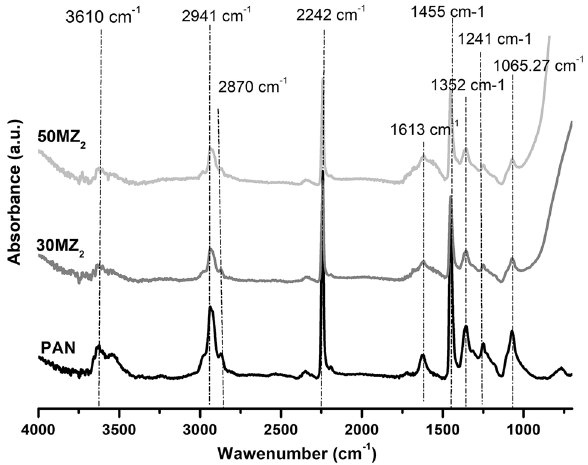
Figure 1. FTIR spectra of PAN, 30MZ 2 and 50MZ 2